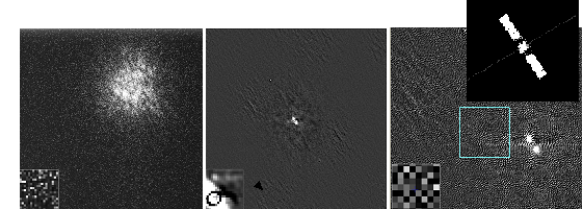
Figure 2. Restored image of the AES «Express AM 2»